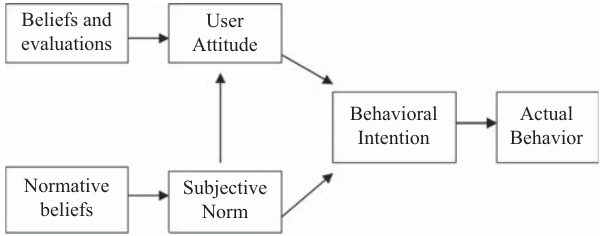
Figure 1. Theory of reasoned action